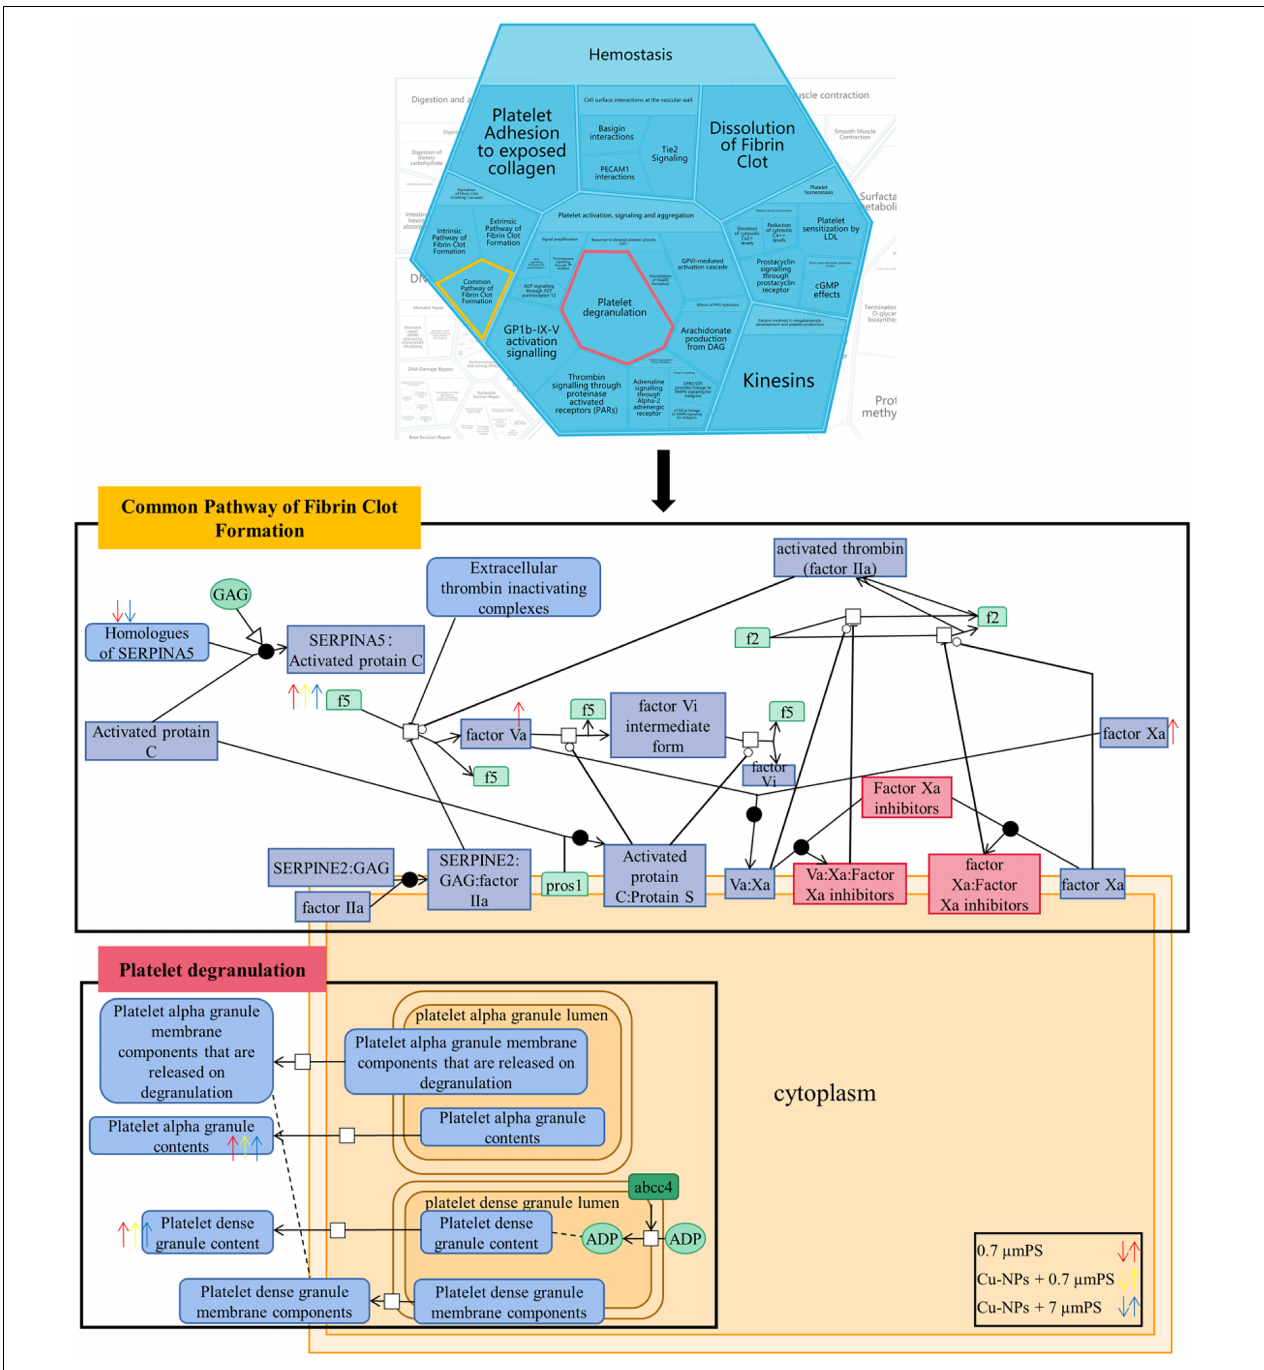
FIGURE 5 | Hemostasis. The platelet degranulation and formation of fibrin clot are the two most representative sub-processes in hemostasis